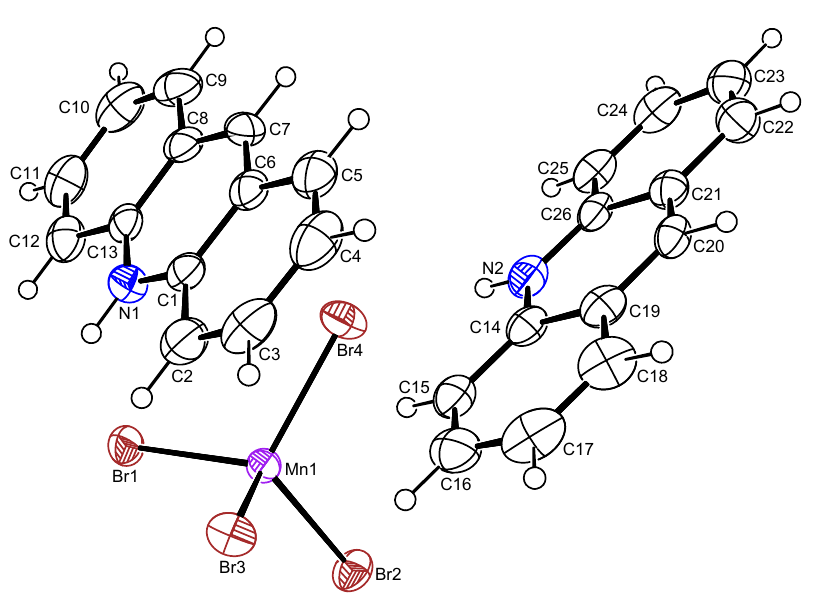
Table  : Data collection and